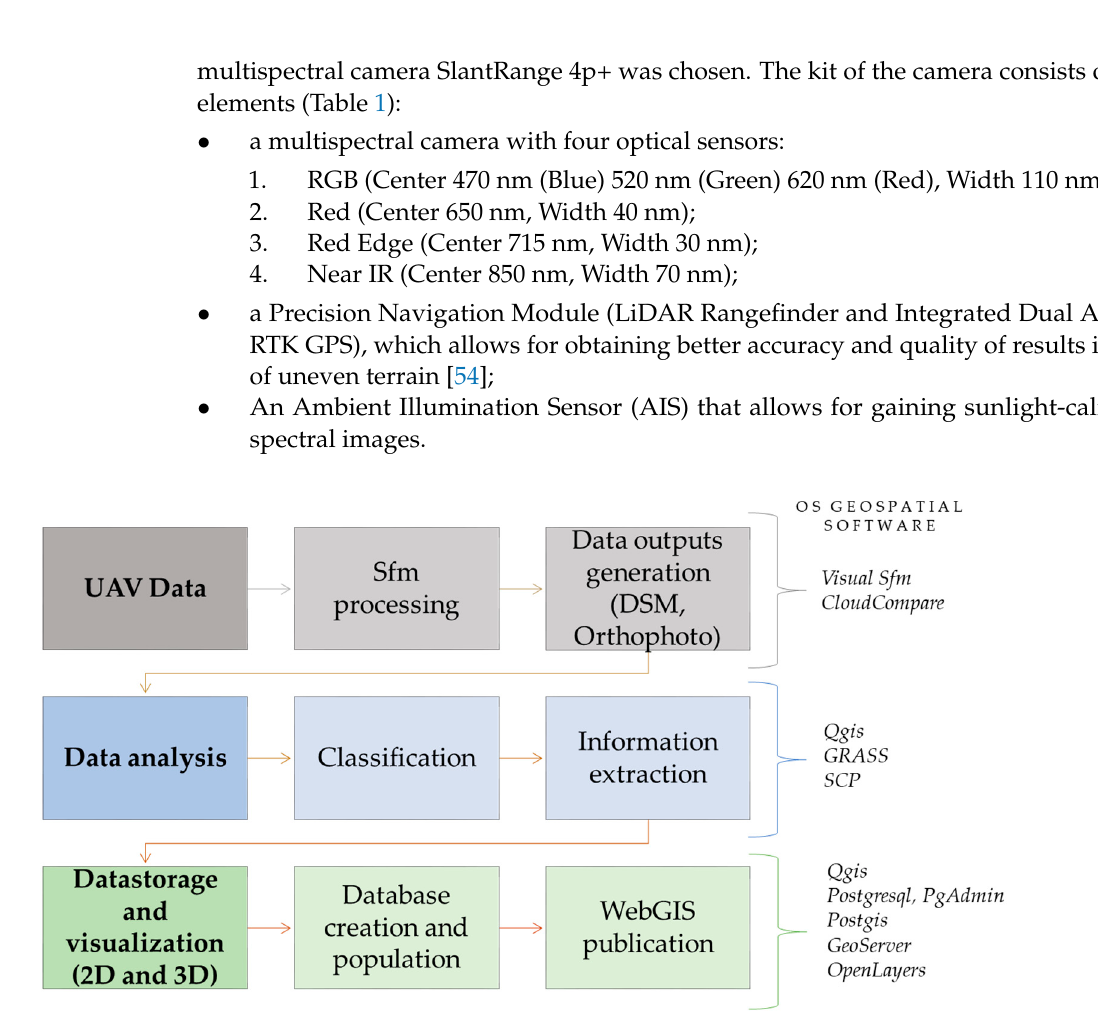
Figure 2. The workflow of the methodology. SfM = Str5ucture from Motion; DSM = Digital Surface Model; SCP = Semi-Automatic Classification Plugin. Table 1. Data acquisition system specifications.